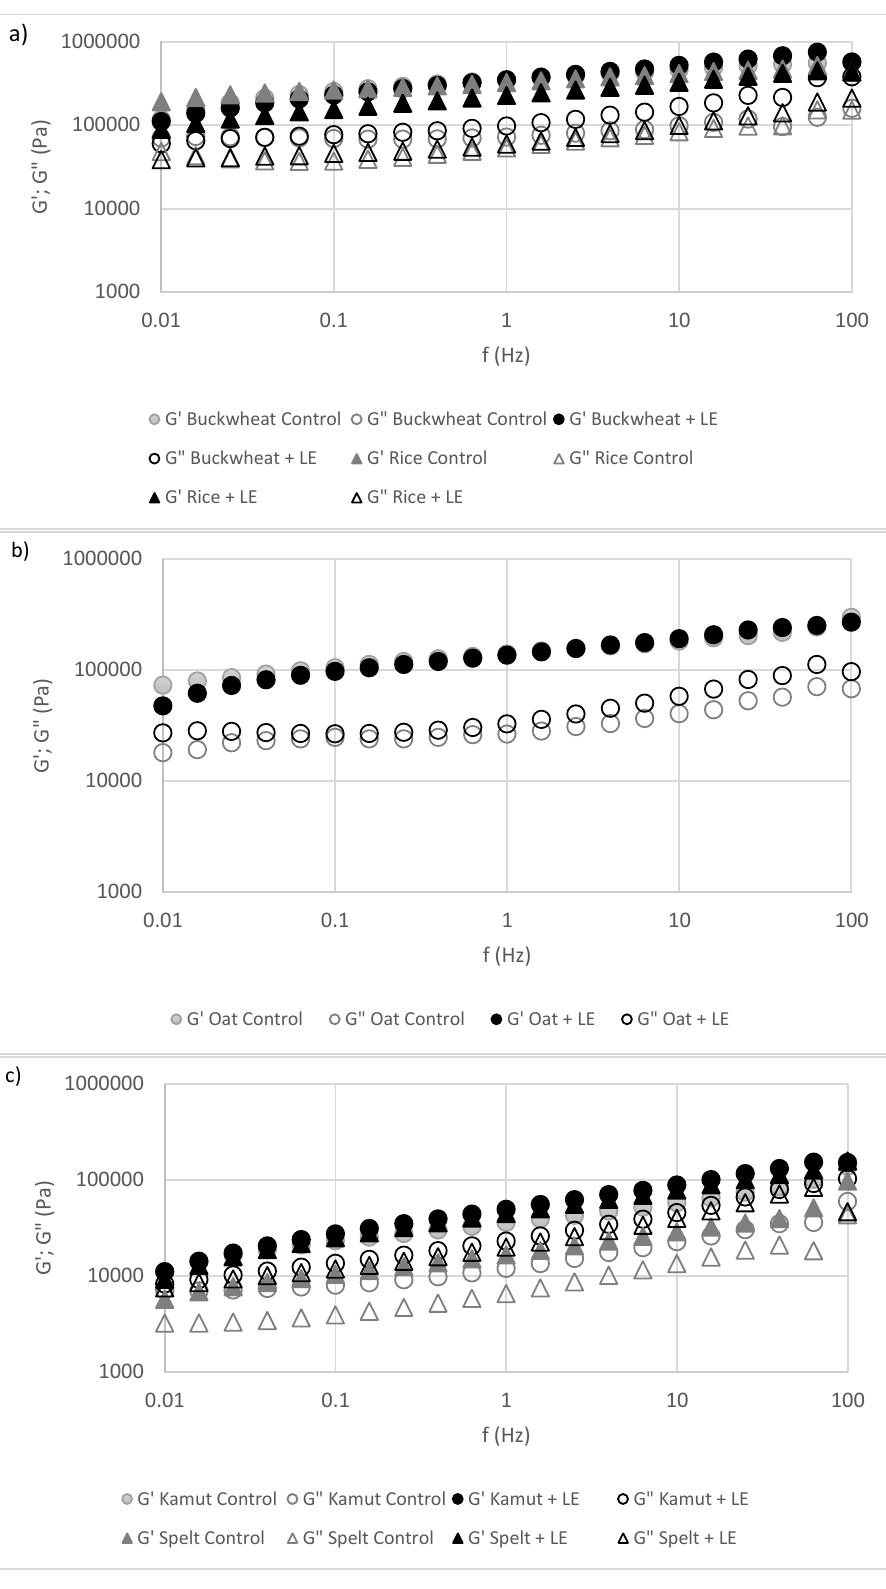
Figure 2. Mechanical spectra of control and LE doughs prepared with alternative flours: ( a ) gluten- free flours, buckwheat and rice; ( b ) oat; ( c ) gluten flours, kamut and spelt. Close symbols represent G’ (elastic modulus) and open symbols represent G” (viscous modulus).